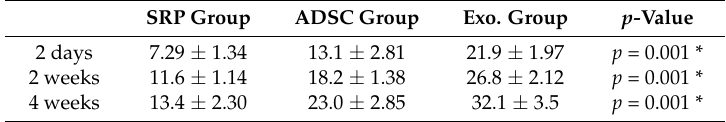
Table 1. Comparison of mean area % values of newly formed tissues for the studied groups (ANOVA test).